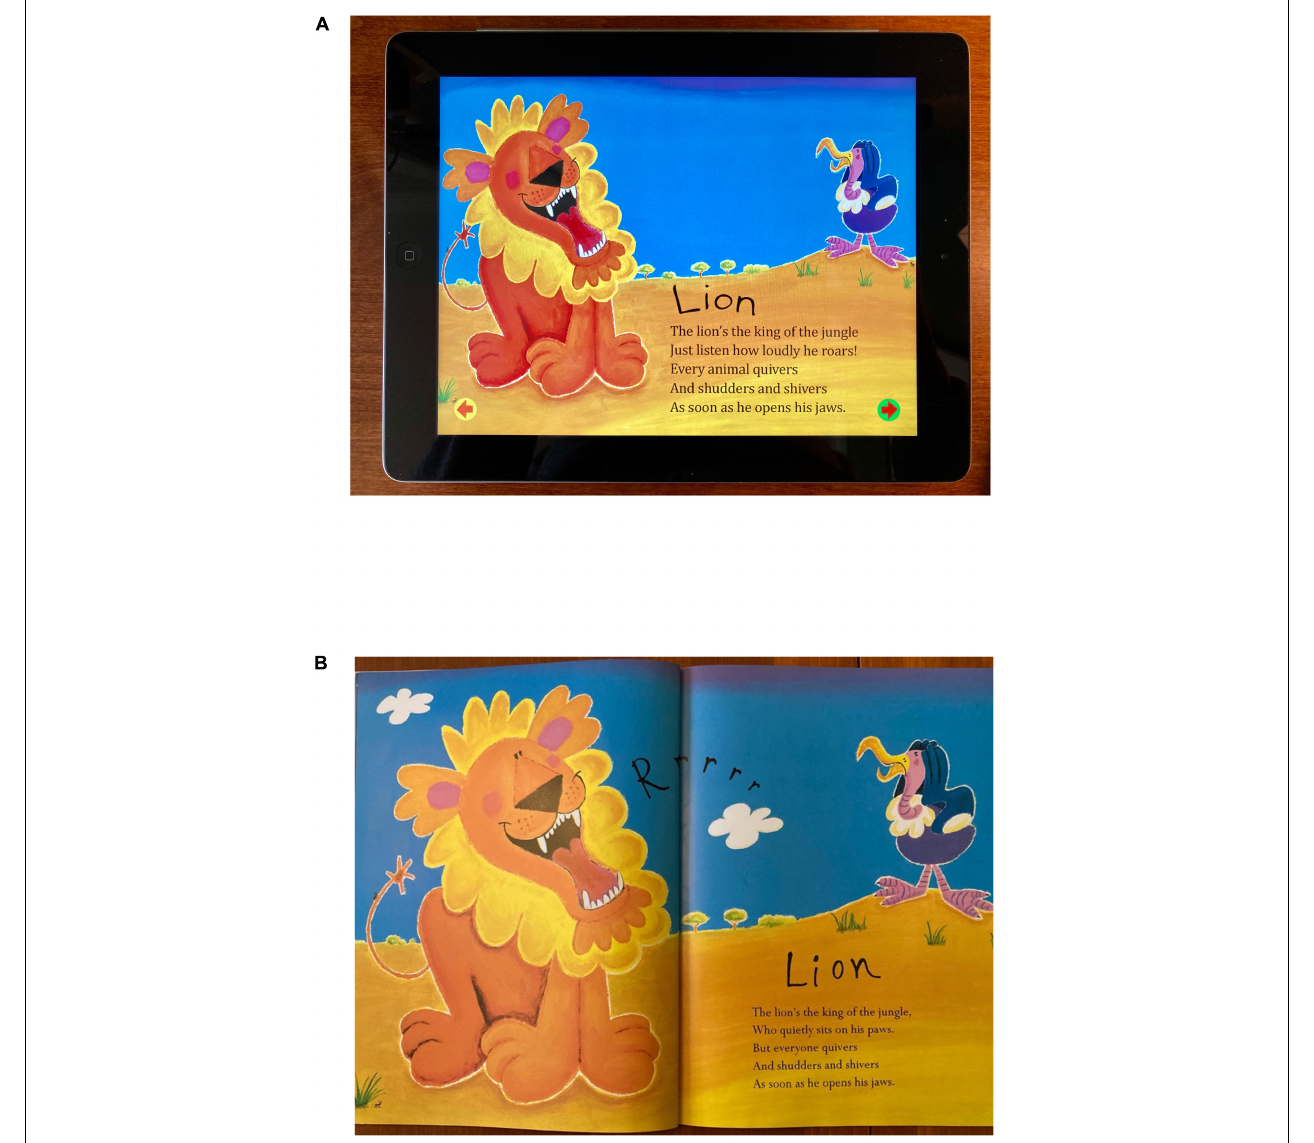
FIGURE 2 | Electronic (A) and paper (B) illustrations from Rumble in the Jungle written by Giles Andreae and illustrated by David Wojtowycz. London, United Kingdom: Orchard Books,